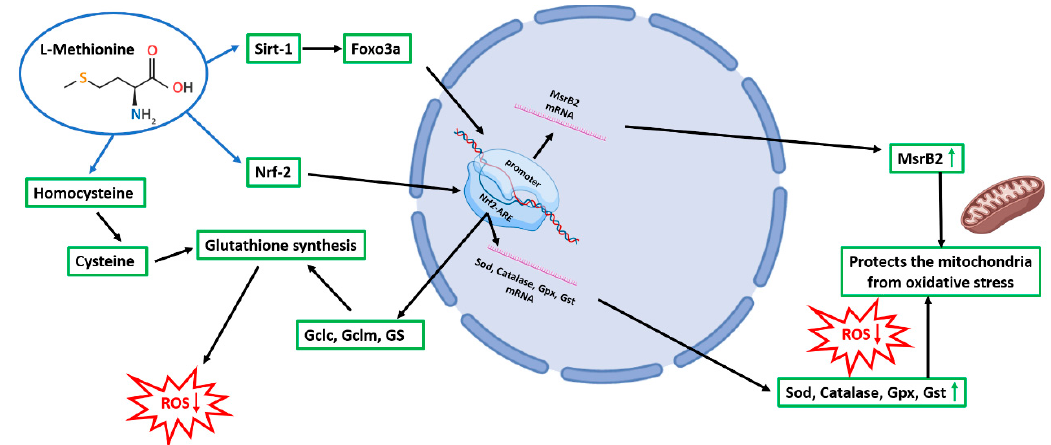
Figure 12. Schematic representation of the underlying mechanisms of Met neuroprotective effects. Gclc: glutamate cysteine ligase catalytic subunit; Gclm: glutamate cysteine ligase regulatory subunit; GS: glutathione synthetase.